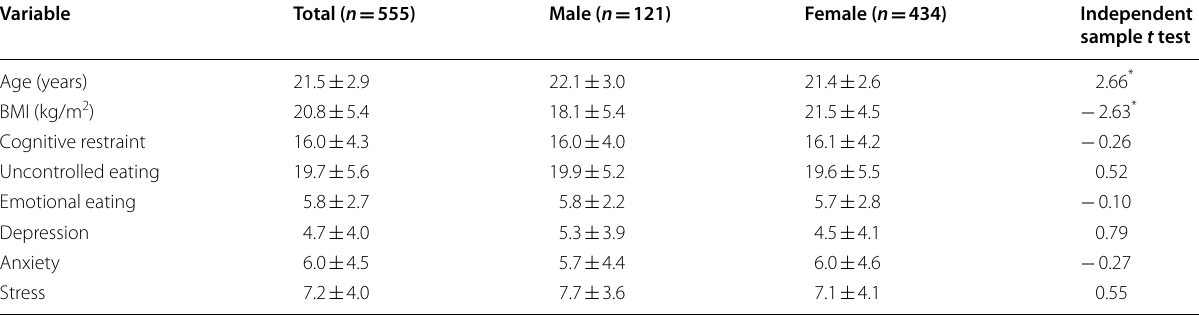
Statistics: data are reported as numbers (mean Comparisons between male and female participants—* P < 0.05 BMI body mass index, n sample